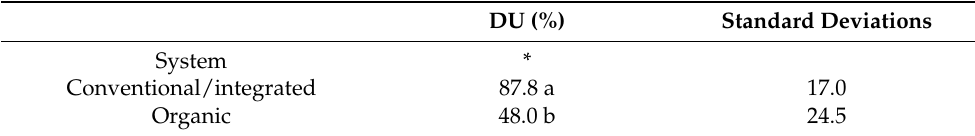
Table 4. Distribution uniformity (%) depending on the production system.